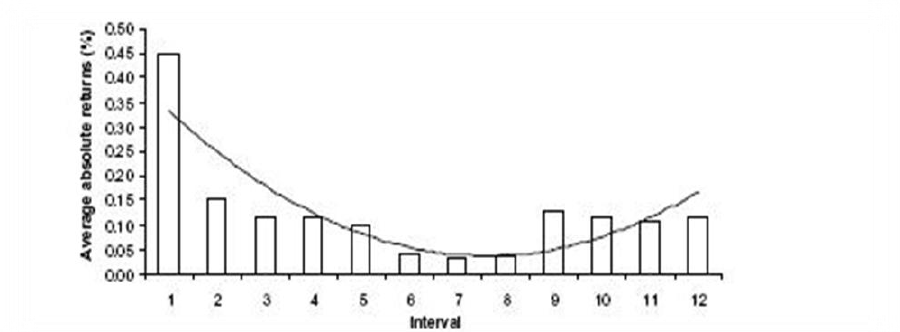
Figure 1. The Histogram for the Absolute Value of Returns during one Trading Day